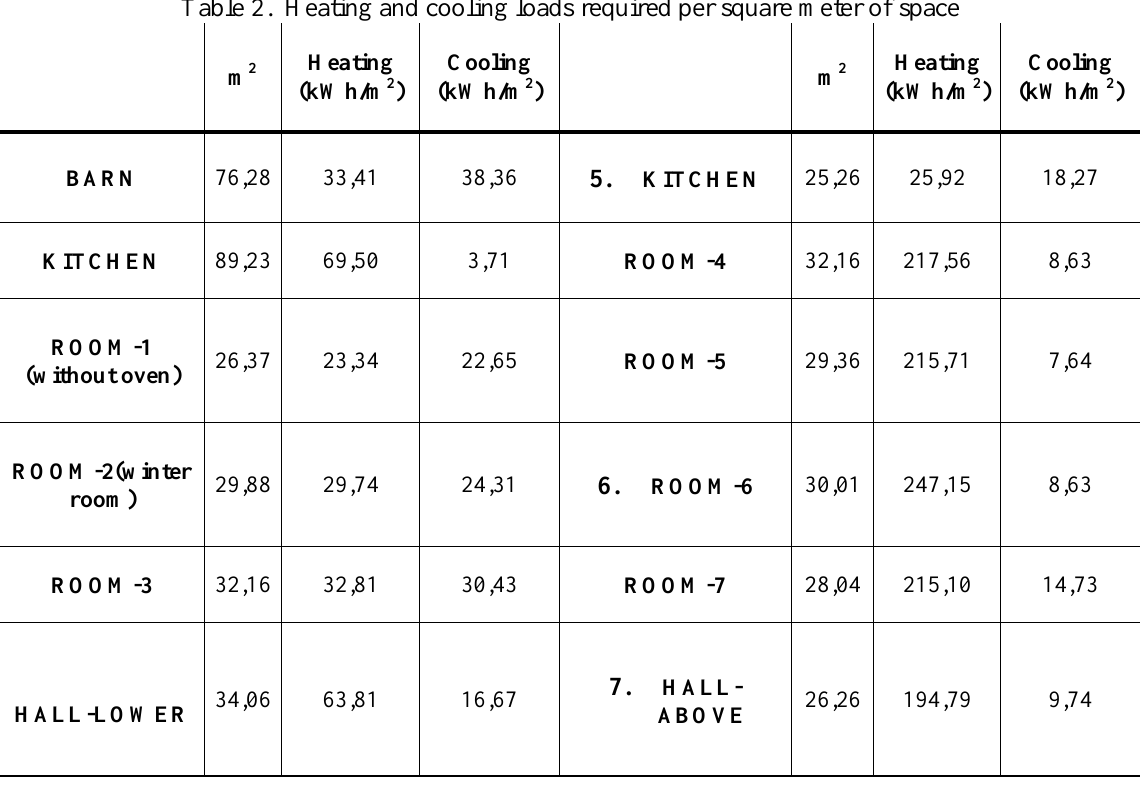
Table 2. Heating and cooling loads required per square meter of space